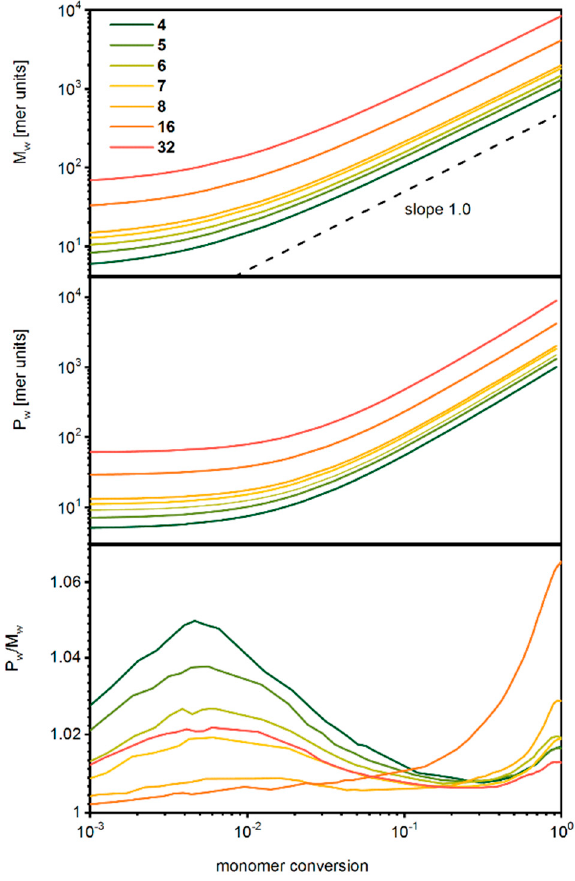
Figure 5. Number-averaged mass (upper panel), weight-averaged mass (middle panel) and dispersity (lower panel) of star-branched polymers as a function of the monomer conversion. The number of arms is given in the legend.